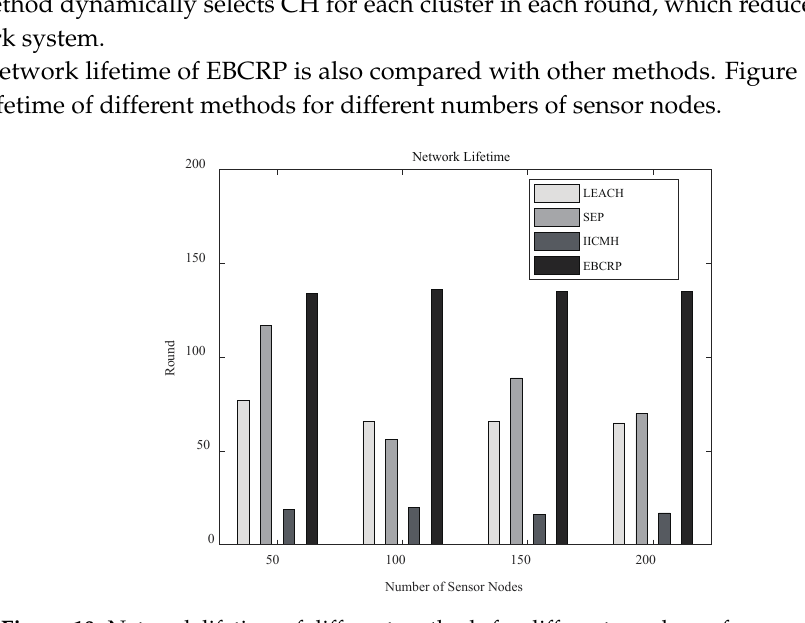
Figure 10. Network lifetime of different methods for different numbers of sensor